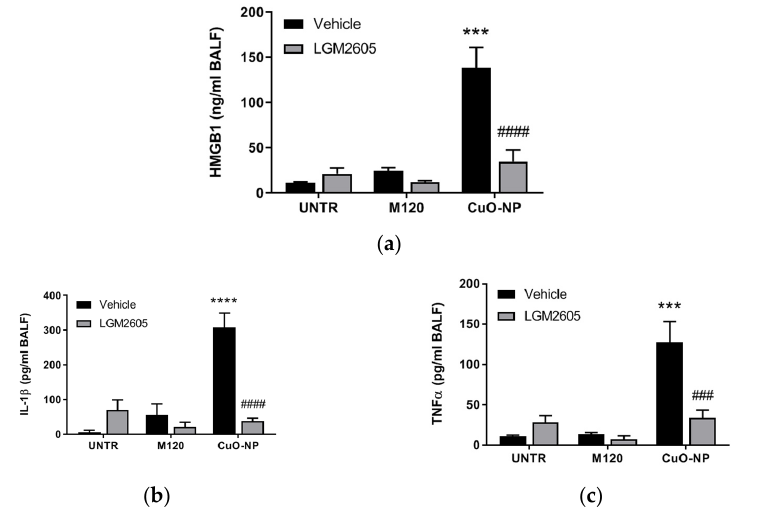
Figure 5. LGM2605 reduces lung levels of CuO-NP-induced inflammasome cytokines. ( a ) BALF HMGB1; ( b ) BALF IL-1 β ; ( c ) BALF TNF α determined at 24 h following instillation of inert carbon control (M120) or 15 µ g CuO-NPs. All data are presented as the mean ± the standard error of the mean ( n = 3–7 per treatment and exposure group). Asterisks indicate a statistically significant difference from their respective unexposed, control group (UNTR) (*** p < 0.001 and **** p < 0.0001) and # indicates a statistically significant difference from Vehicle (### p < 0.001 and #### p <